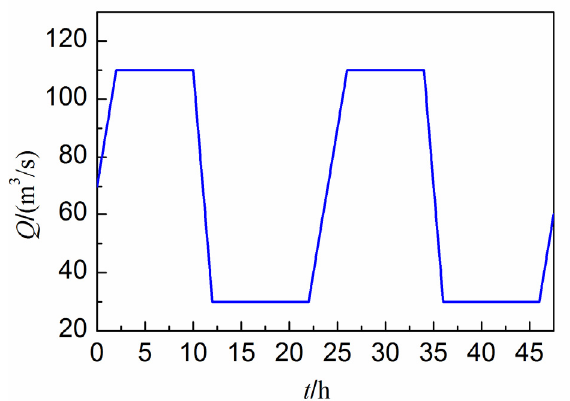
Figure 6. Gas demand at the outlet.